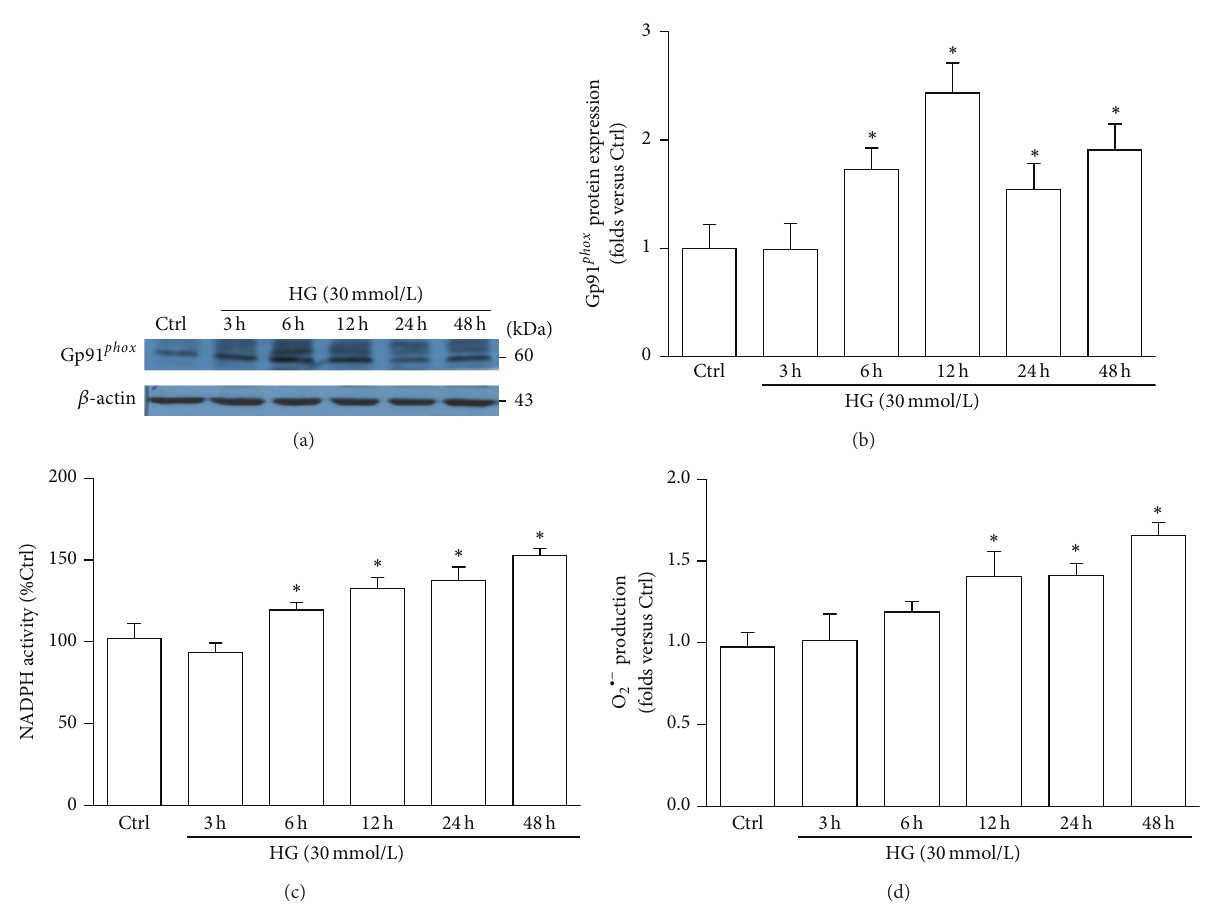
Figure 3: In HG-stimulated podocytes the expression of gp 91 𝑝ℎ𝑜𝑥 is enhanced. (a) Western blotting gel document showing the expression of gp 91 𝑝ℎ𝑜𝑥 in cultured human podocytes without or with HG treatment for indicated time. (b) Summarized data of protein expression of gp 91 𝑝ℎ𝑜𝑥 in podocytes without or with stimulation of HG ( 𝑛 = 7 ). (c) Summarized data showing the effect of HG on NADPH activity in cultured human podocytes ( 𝑛 = 5 ). Data were presented as percent increases in ethidium fluorescence compared to Ctrl. (d) Summarized data showing the fold changes in O 2∙− production, which are normalized to Ctrl ( 𝑛 = 7 ). Ctrl: control; HG: high glucose. ∗ 𝑃 < 0.05 compared with